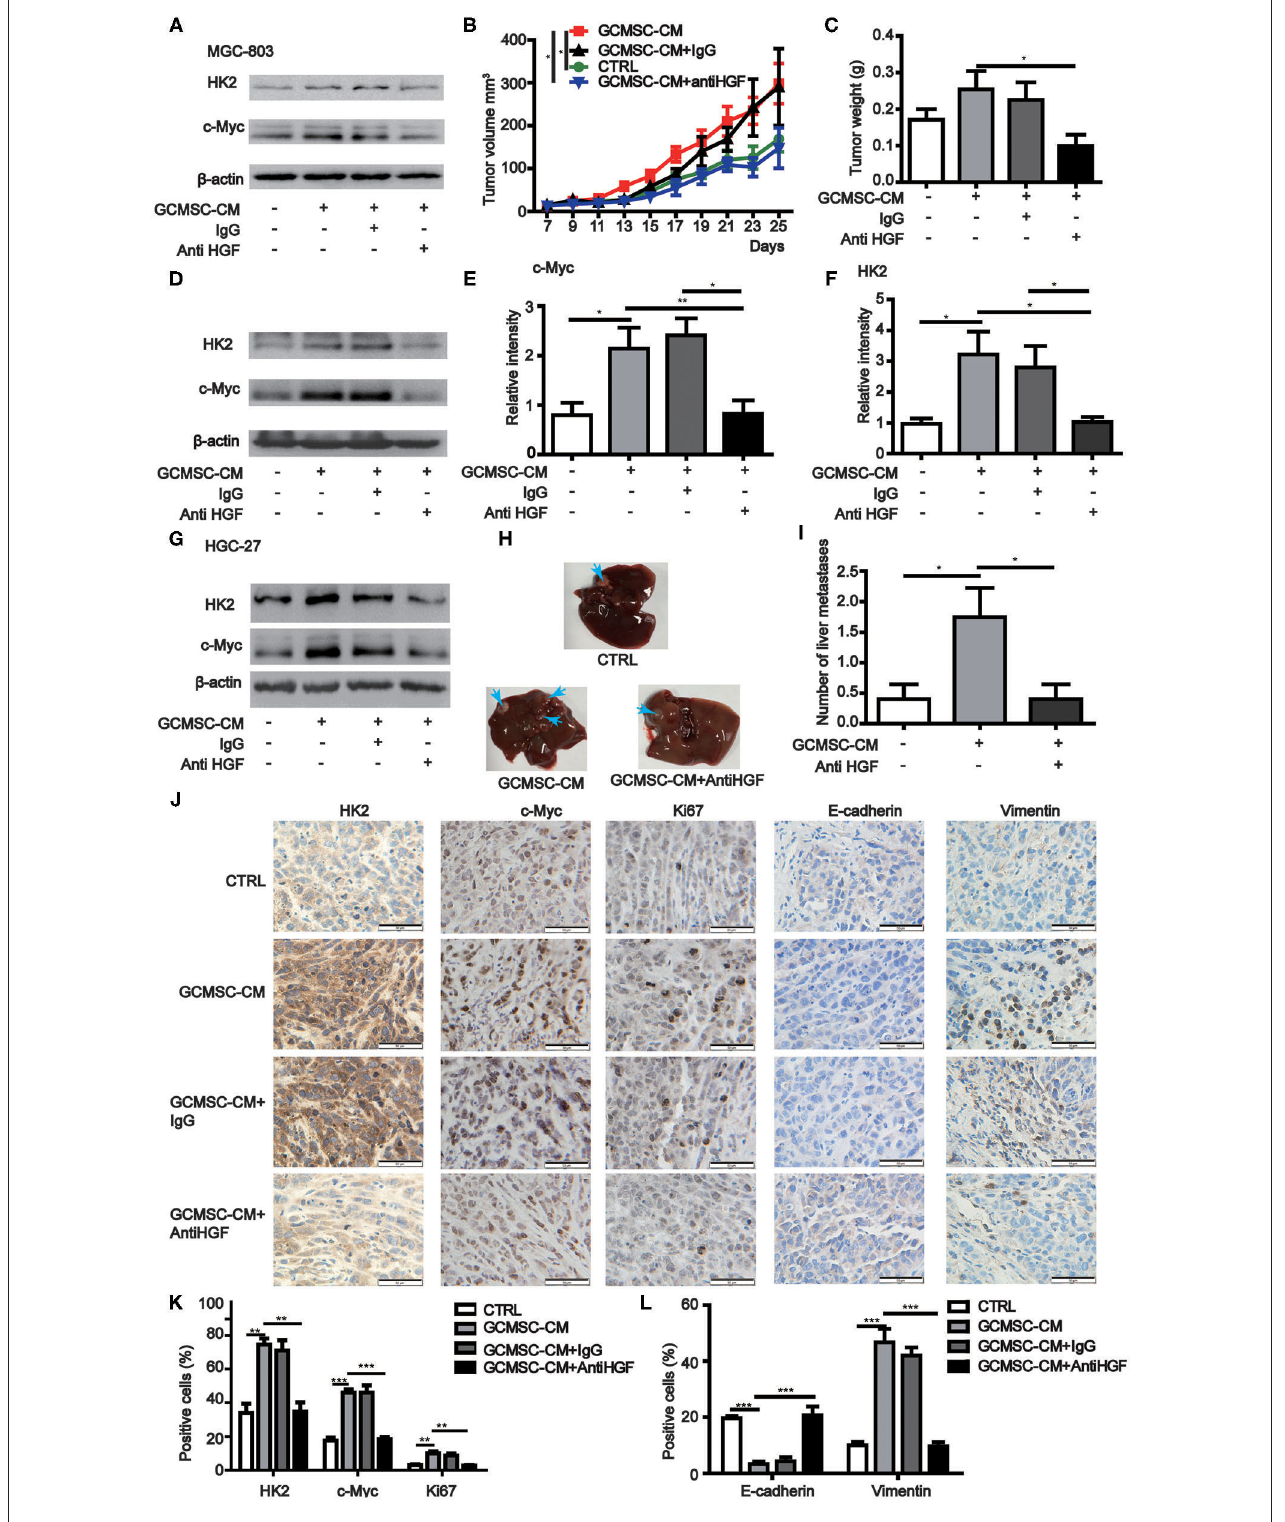
FIGURE 5 | GCMSCs-derived HGF promotes proliferation, metastasis, and angiogenesis of gastric cancer cells in vivo . (A) Immunoblotting of the HK2 and c-Myc expression in MGC-803 cells treated with the indicated reagent for 48h in vitro . (B,C) Growth curves (B) and tumor weights at day 28 (C) of mice injected